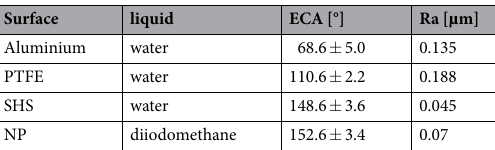
Table 1. ECA of the surfaces, at temperature T 0 = 20 °C, measured with sessile drop method. The mean surface roughness (R a ) is also